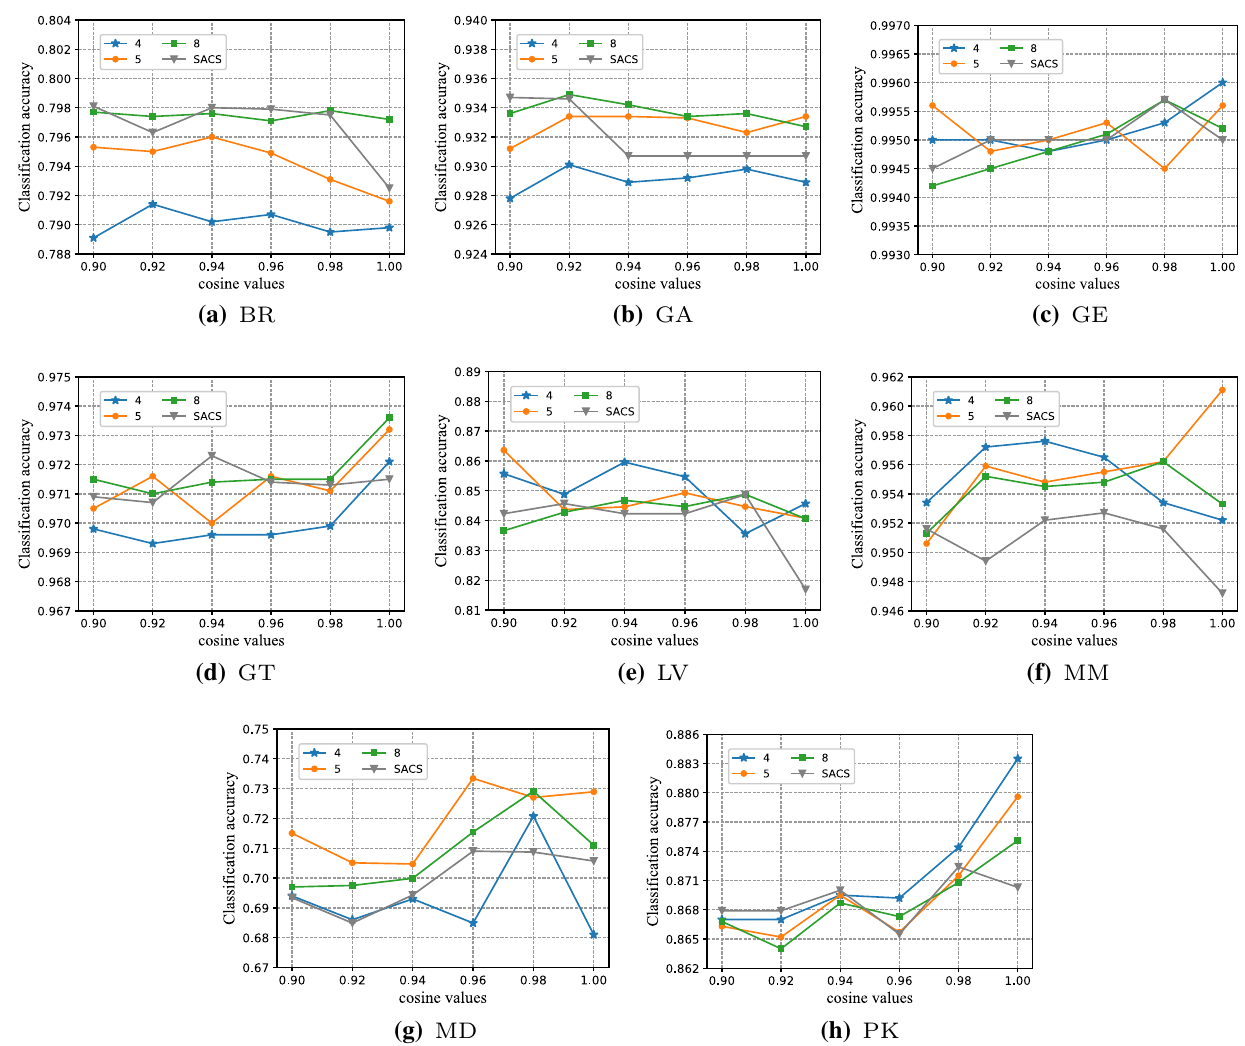
Fig. 1 Classification accuracy for the eight datasets with different cosine values. ( SACS represents the result of selecting attributes of the algo- rithm 1 under different cosine values settings. The 4, 5, and 8 indicate the number of attributes in each partitioned data